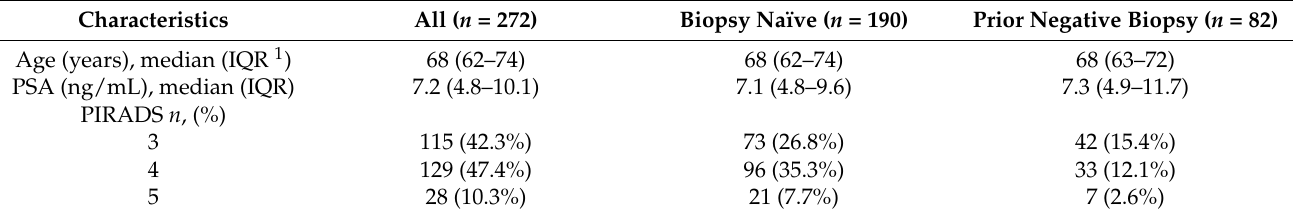
Table 1. Characteristics of the participants. 1 IQR, Inter-Quartile